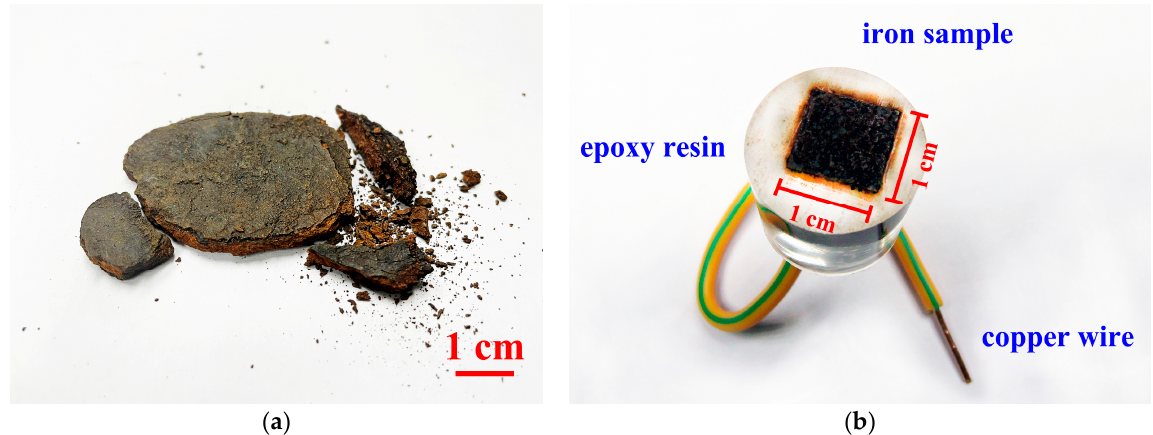
Figure 1. Archaeological iron artifacts from the Nanhai I ( a ); working electrode ( b ).